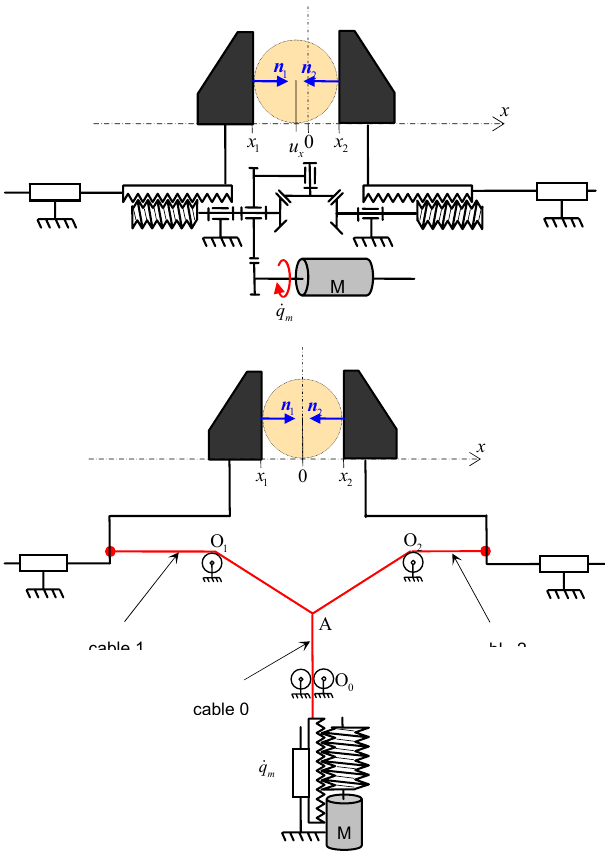
Figure 2. Diagram representing a two contact